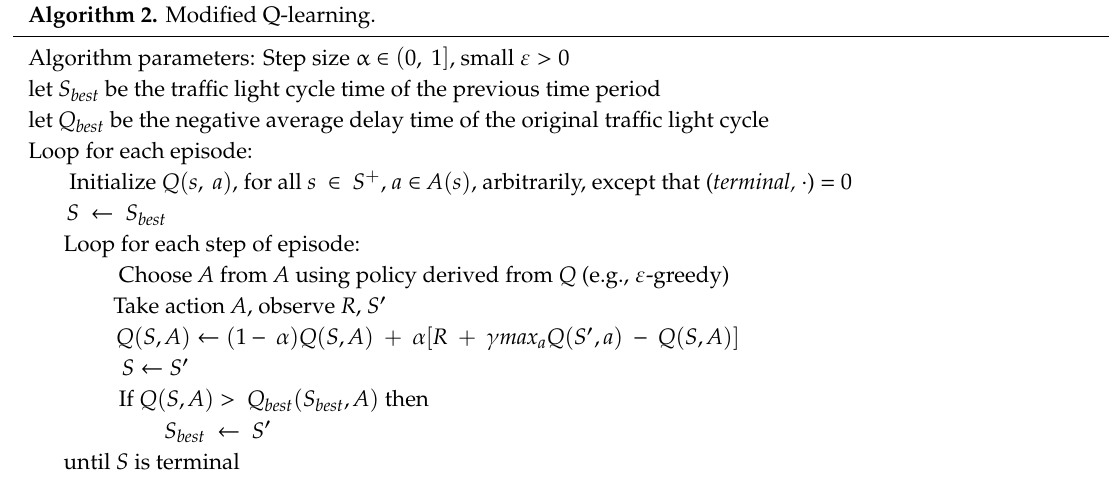
Algorithm 2. Modified